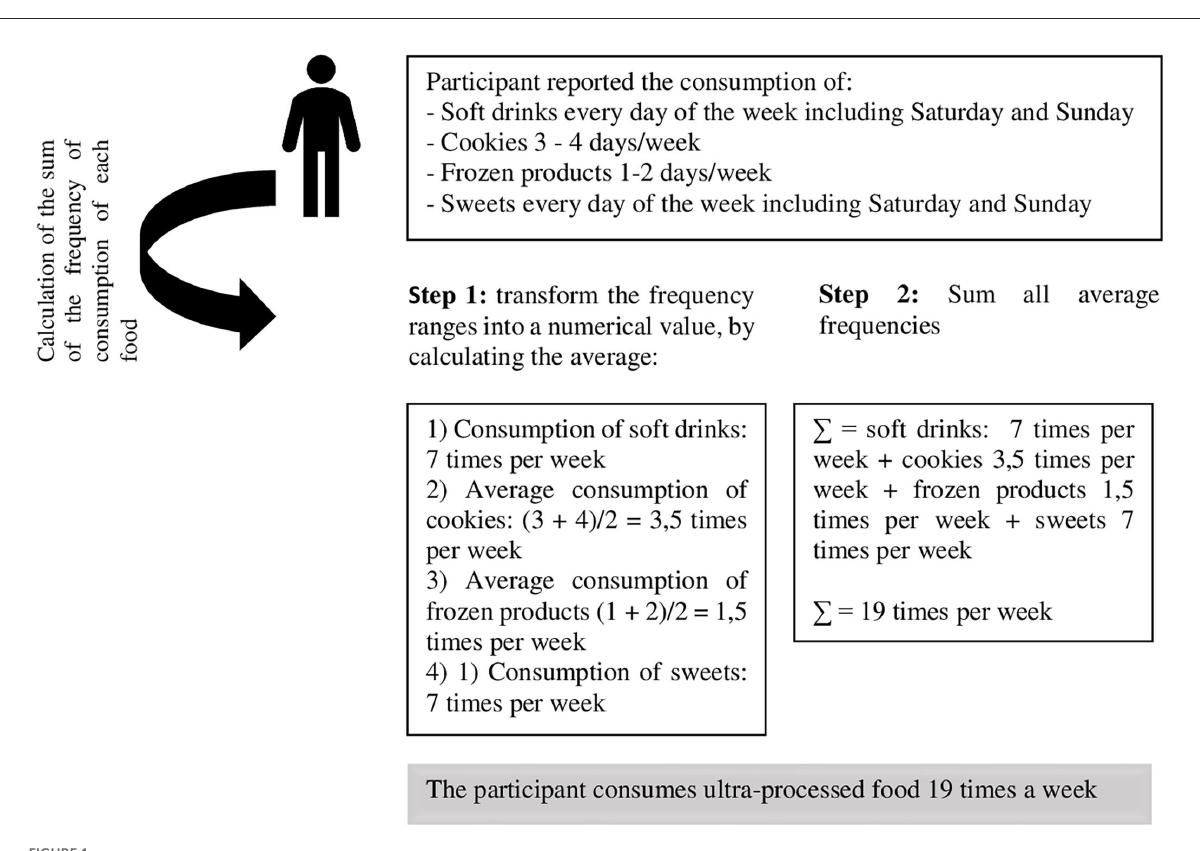
FIGURE1 An example of how the exposure variable, high consumption of ultra-processed foods, was created, COVID Inconfidentes 2020.